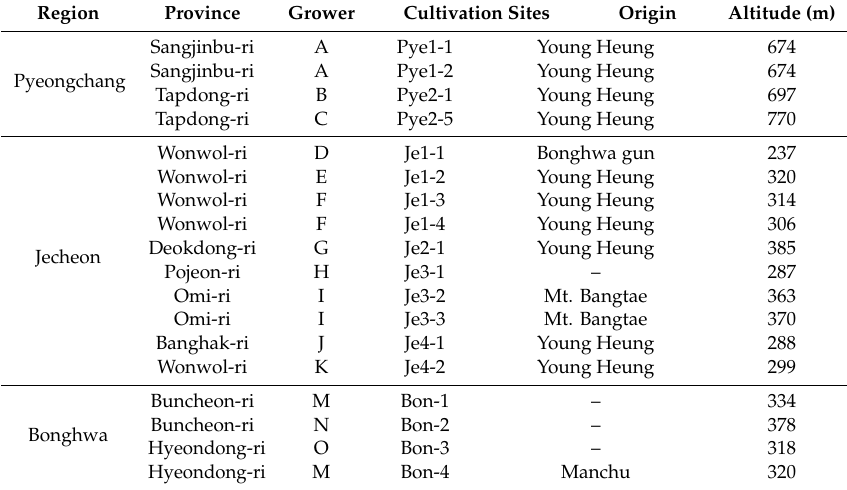
Table 9. Angelica gigas Nakai cultivation sites on 2017 in Pyeongchang, Jecheon, and Bonghwa, Korea. Region Province Grower Cultivation Sites Origin Altitude